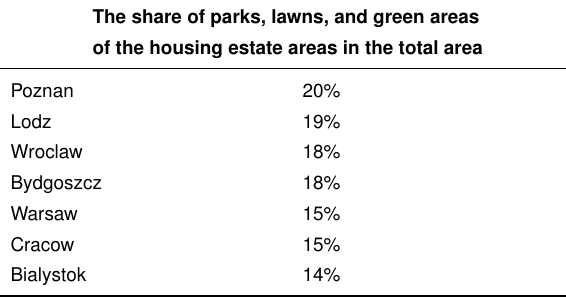
Table 1. Green urban area